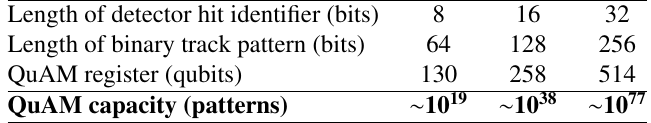
Table 1: QuAM requirements and capacity as a function of width of a detector hit